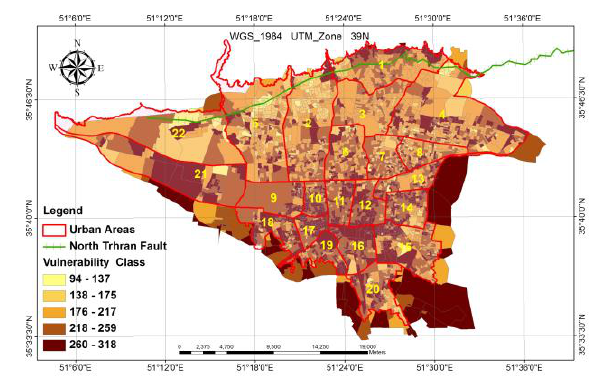
Figure 5. Vulnerability map for “All”